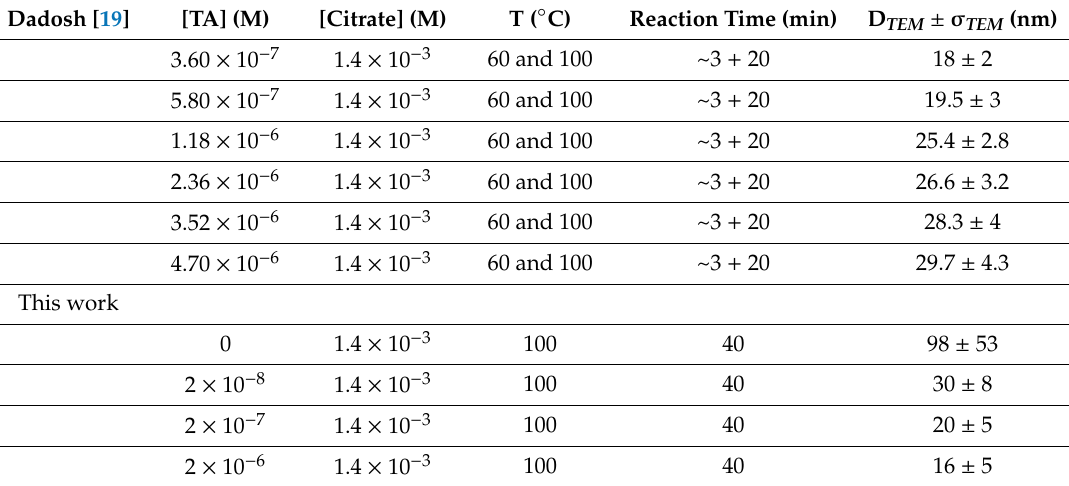
Table 1. Comparison of experimental conditions and size of